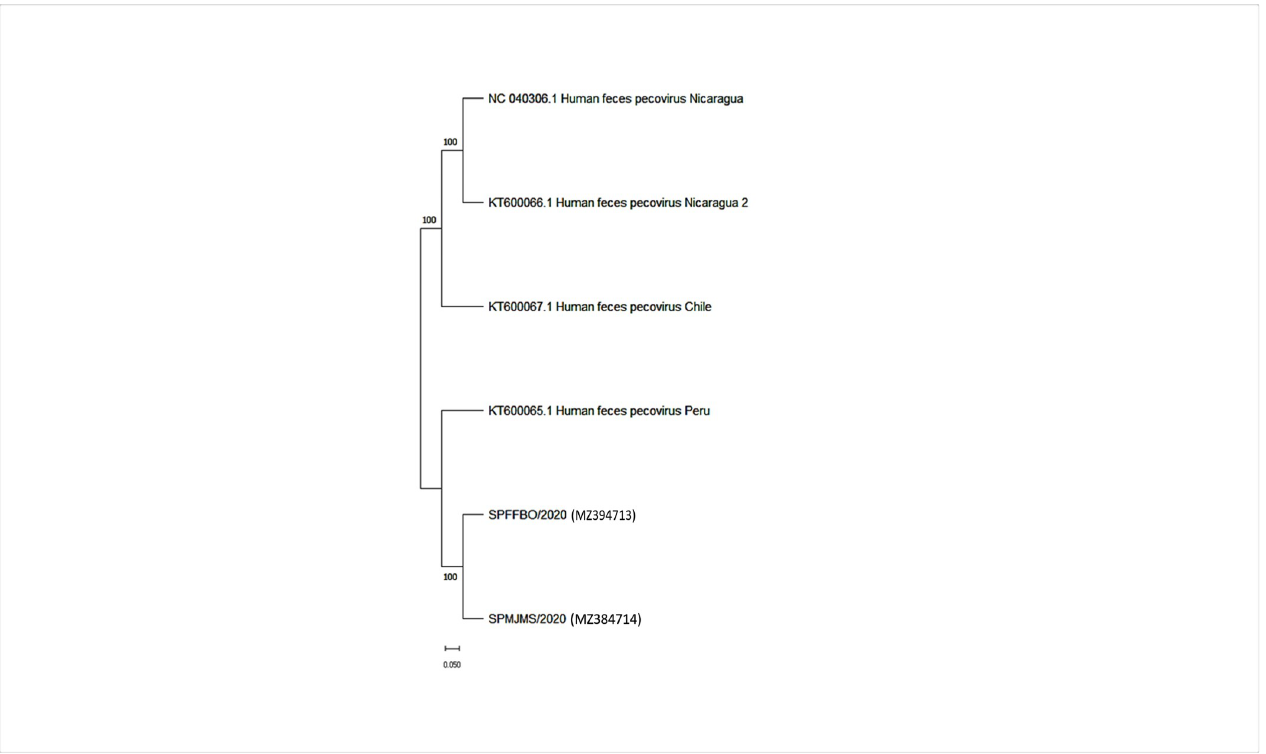
Fig 3. The construction of the phylogenetic tree was performed using the Maximum Likelihood test model. In addition, we used the GTR+ gamma correction and the proportion of the invariant sites model, as selected by the Modeltest software. Branch support was achieved by approximate likelihood ratio test (aLRT) and is shown in a color scale. Pecoviruses identified in this study are highlighted in gray. Hosts in which viruses were identified are indicated in